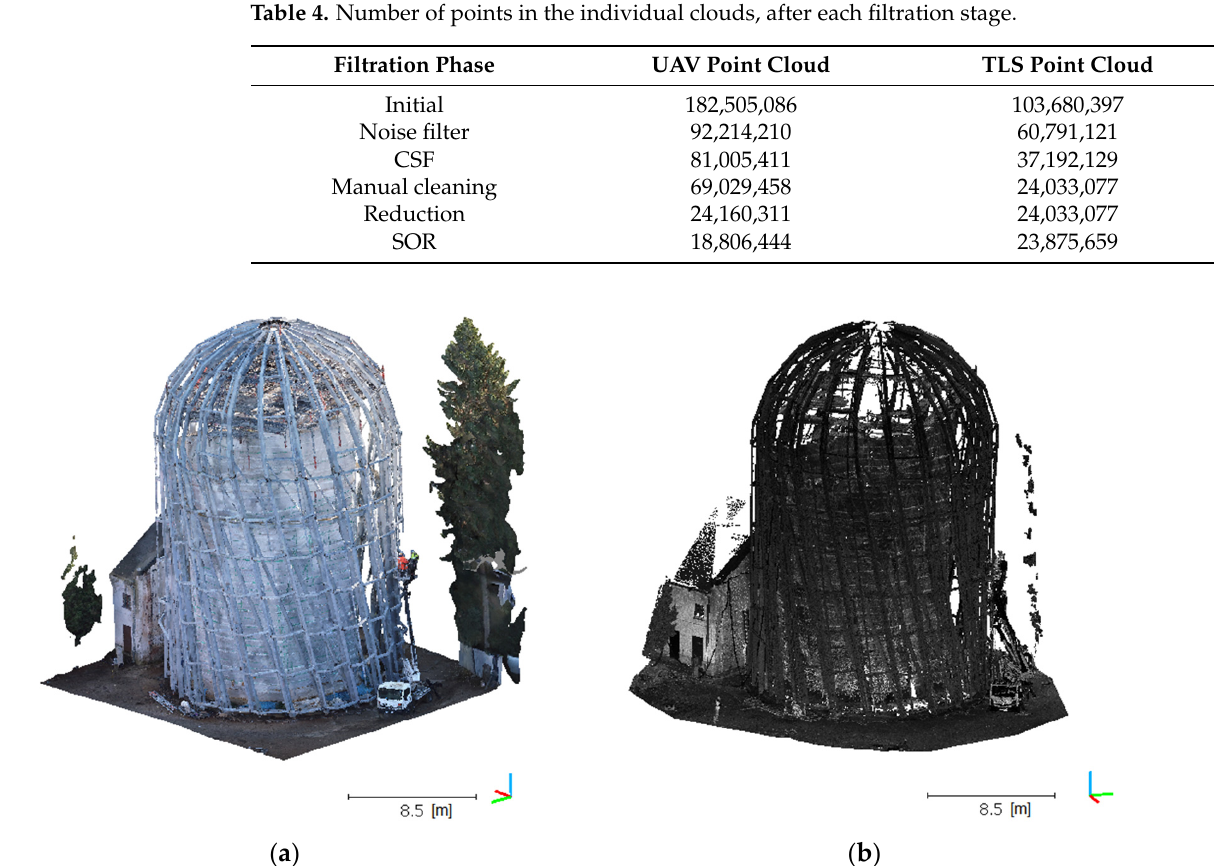
Figure 6. Point clouds after noise filtration for UAV ( a ) and TLS ( b